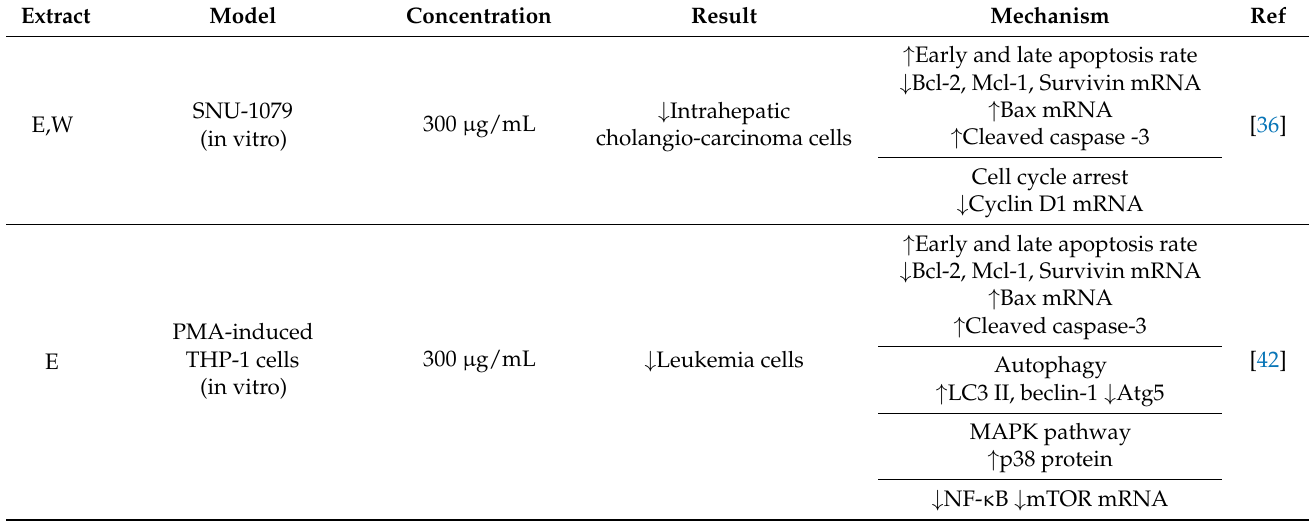
Table 1. Antiproliferative effects and molecular mechanisms of O.